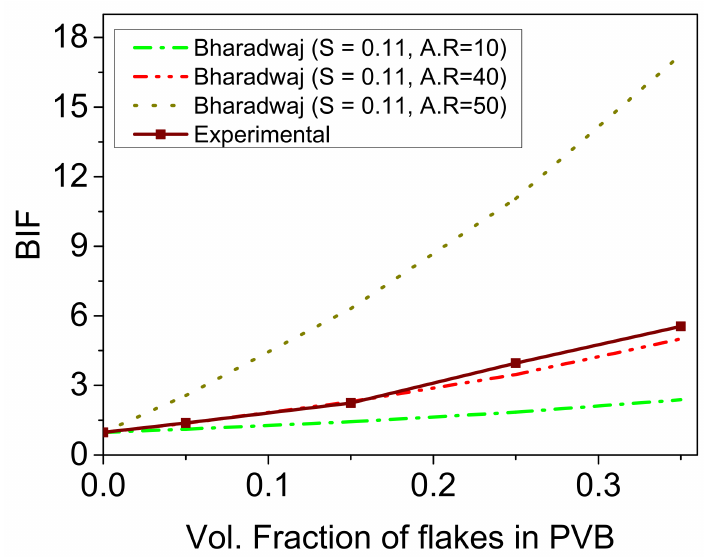
Figure 4. Experimental relative permeability of prepared composites compared with theoretically calculated relative permeability based on Bhardwaj’s model for different aspect ratios (AR) of